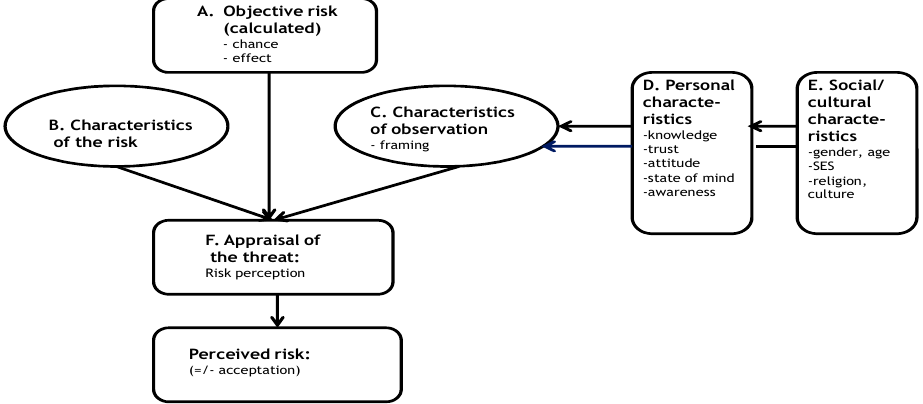
Figure 1. Factors that influence the risk perception of the consumer (adapted from